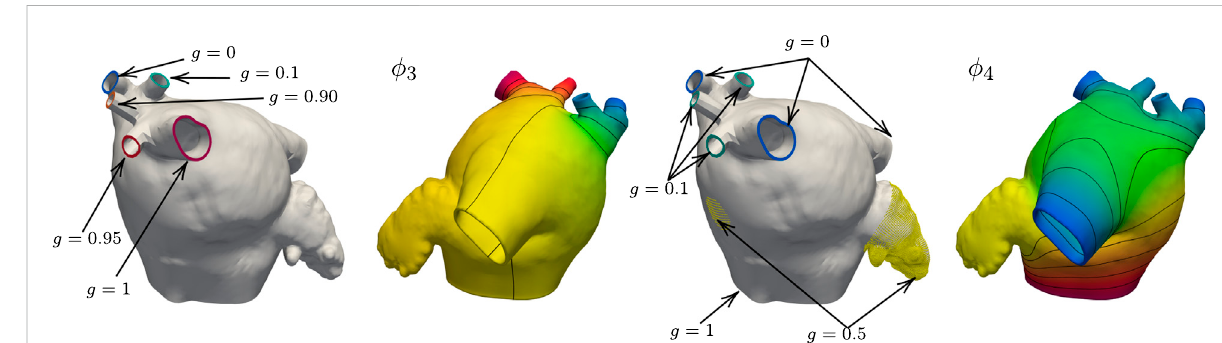
FIGURE 5 Boundary data and harmonic solutions on M52. We set g = 0 on the right inferior PV and g = 1 right superior PV when solving for ϕ 3 . The accessory PVs are set to intermediate values between 0 and 1. On the left common pulmonary trunk we impose natural boundary conditions. This fi eld is used to de fi ne the anterior and posterior walls. The boundary conditions for ϕ 4 are g = 0 on the right superior, inferior, and left common PVs. Thevalueof g onthethreerightPVsthatliebetweenthesuperior-mostandinferior-mostis0.1.TheboundaryconditionontheMVringis g =1, and the LAA and FO regions are set to 0.5.